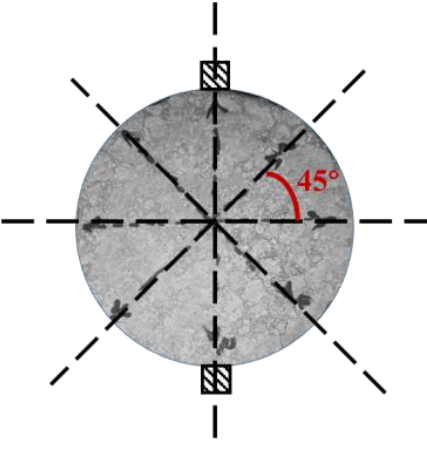
Figure 5. ITSM test from four directions.